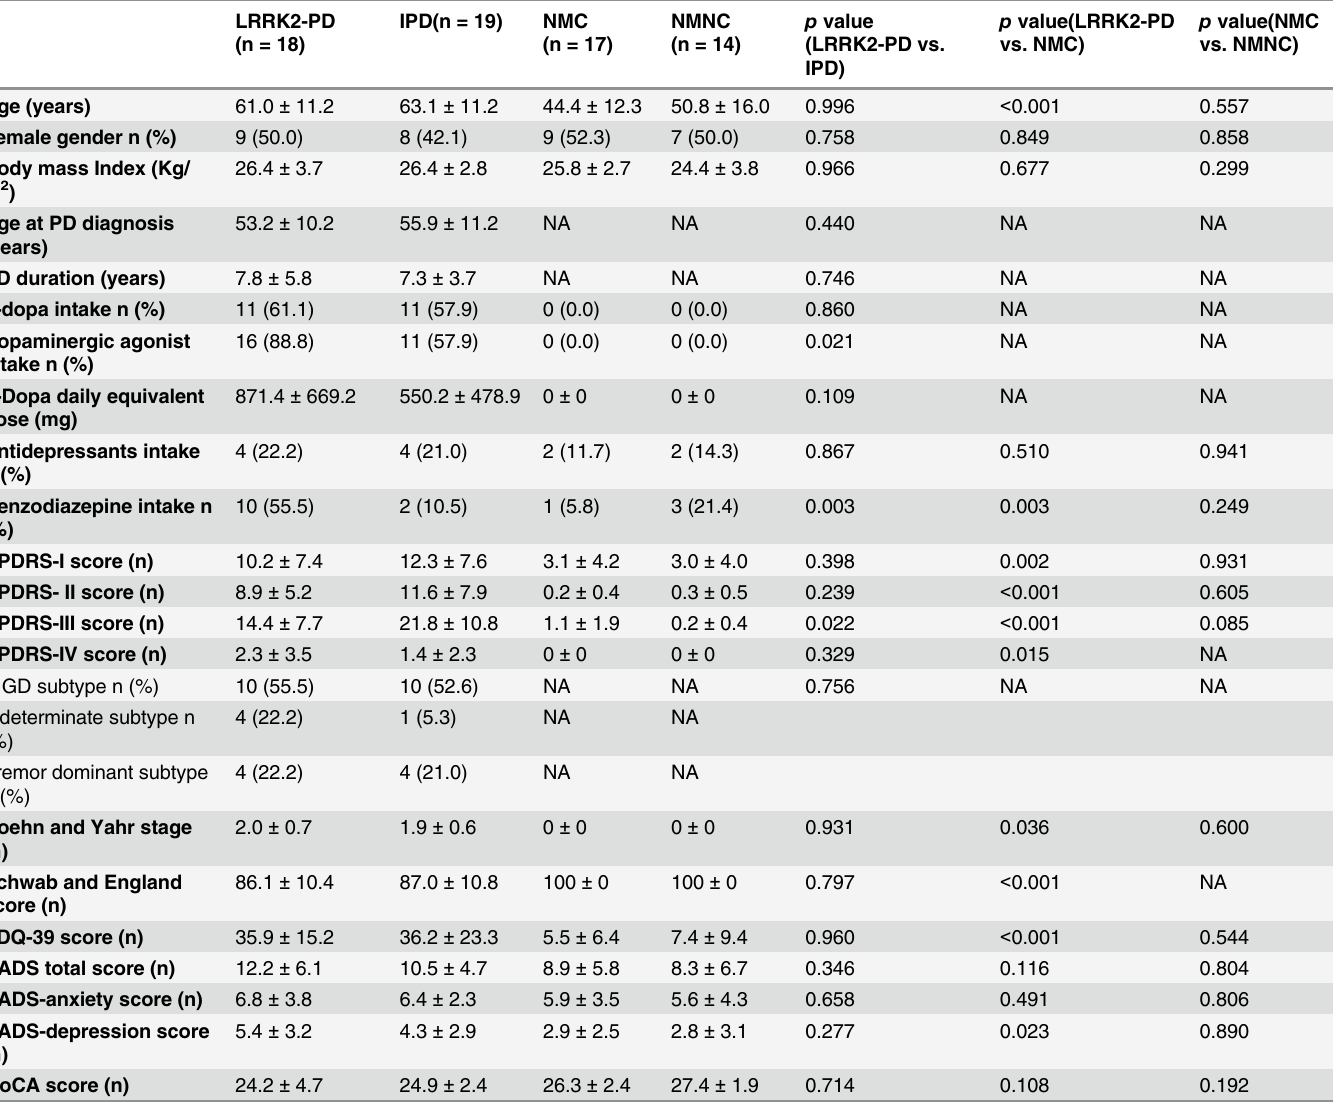
Table 1. Demographic and parkinsonian clinical data and comparisons between groups.